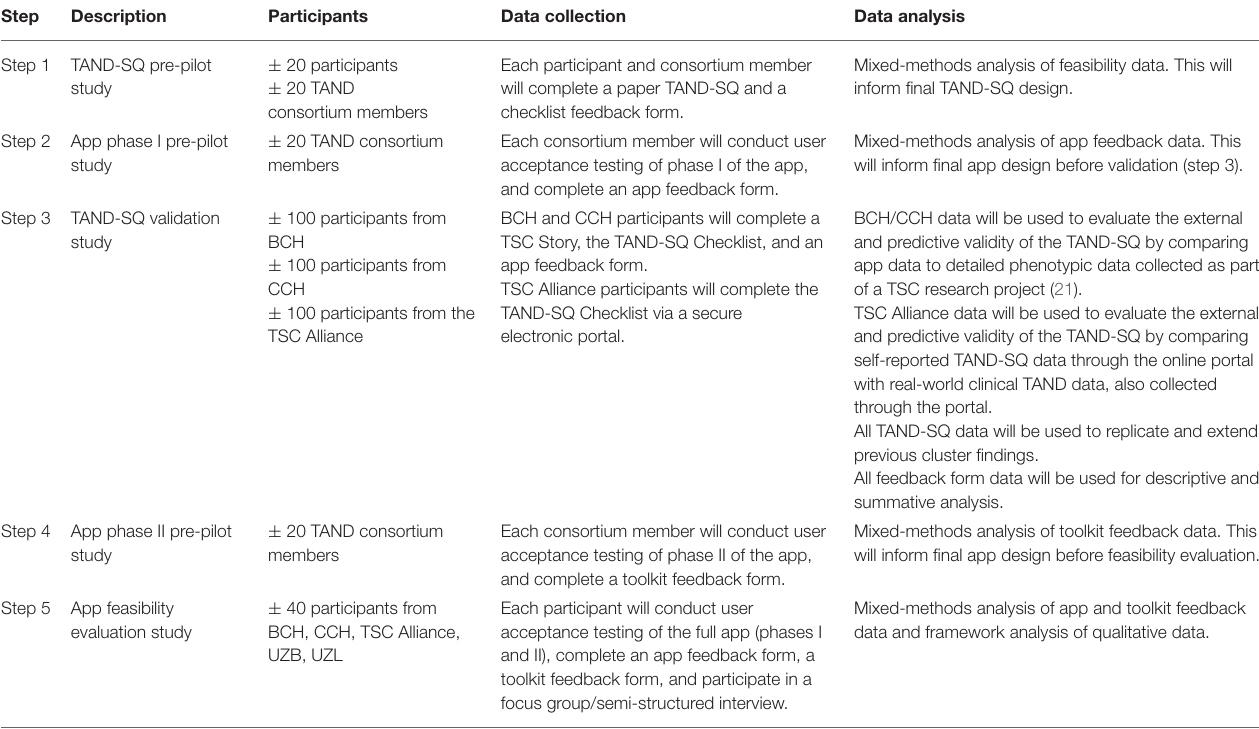
TABLE 3 | Steps of data collection and